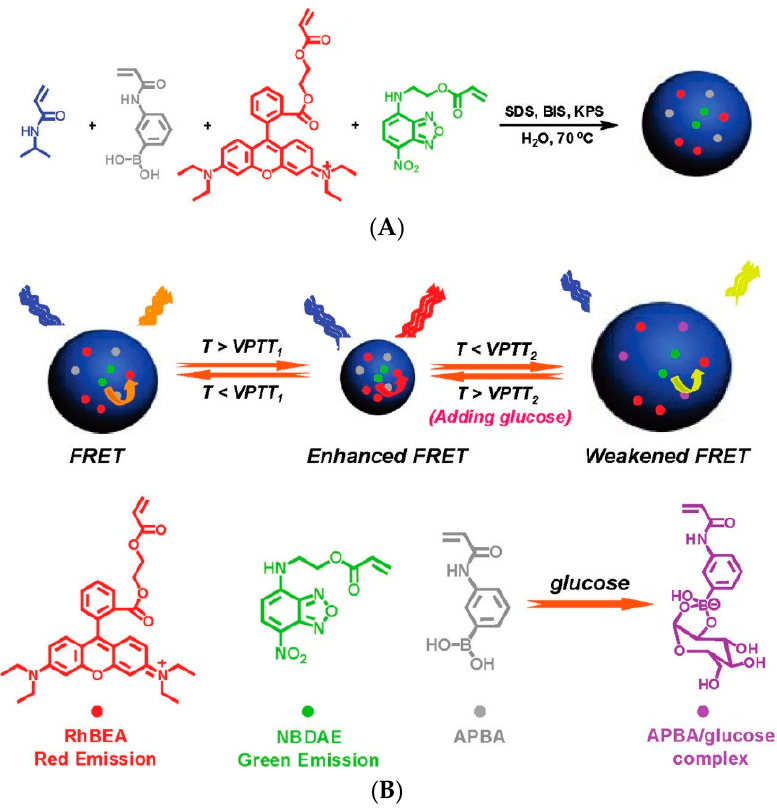
Figure 9. ( A ) Synthetic schemes employed for the preparation of thermo- and glucose-responsive P(NIPAM-APBA-NBDAE-RhBEA) fluorescent microgels via emulsion polymerization. ( B ) Schematic illustration for the modulation of FRET efficiencies within P(NIPAM-APBA-NBDAE-RhBEA) microgels by temperature variations and the addition of glucose [88]. Copyright 2011 American Chemical Society.